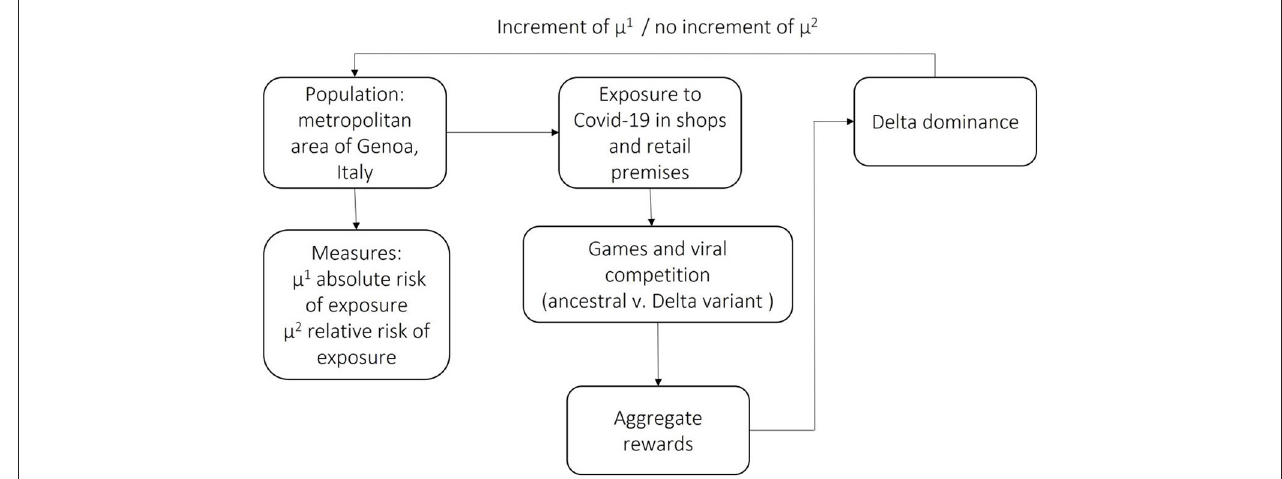
FIGURE 1 | Delta variant evolutionary